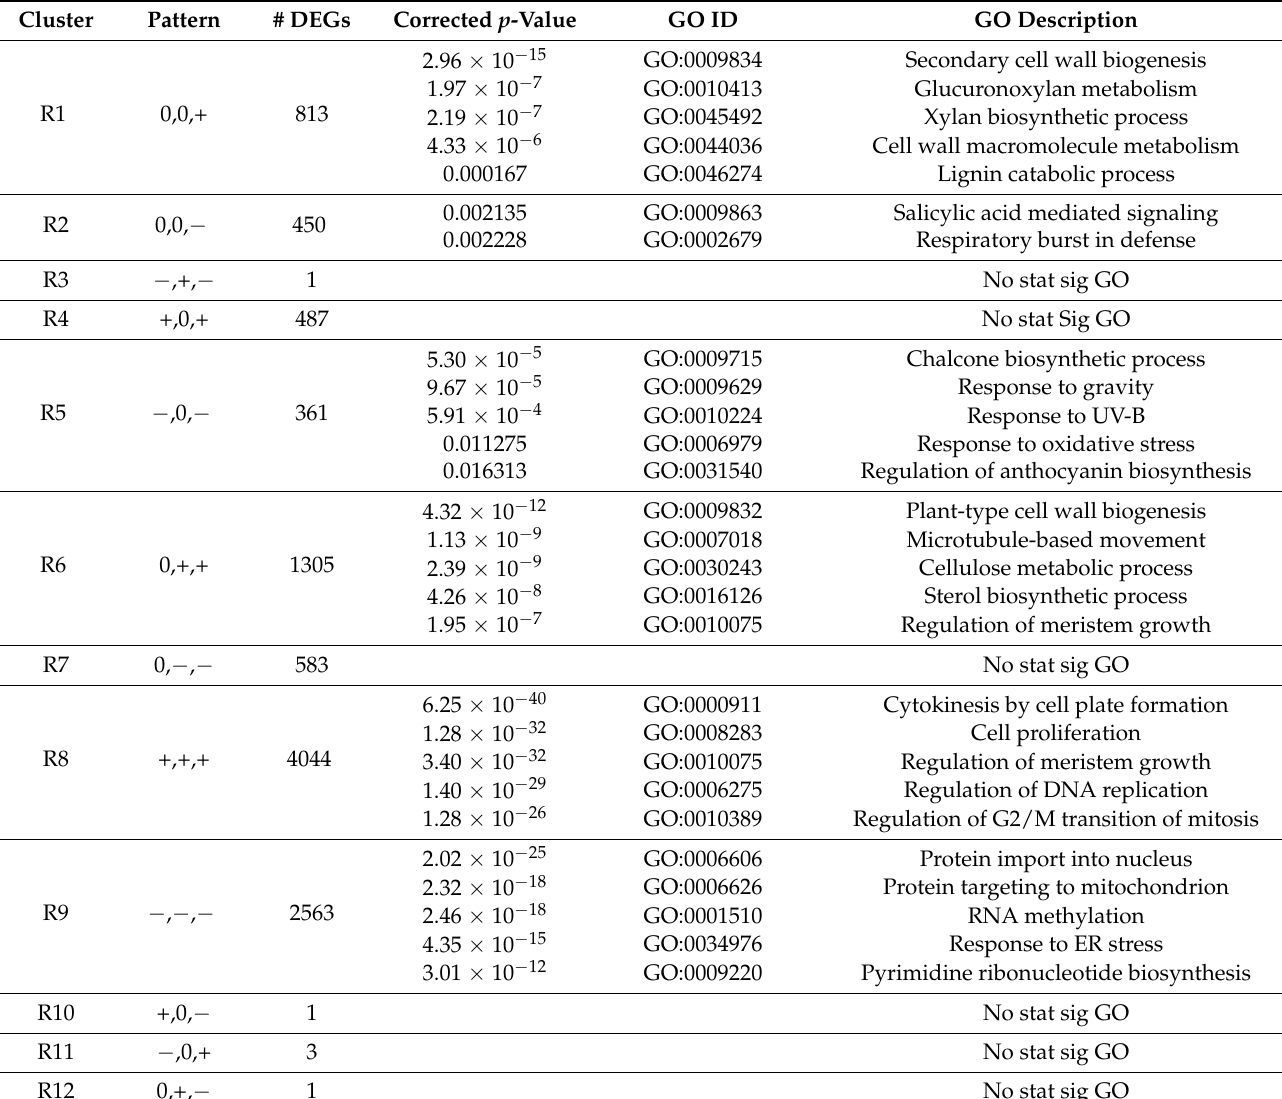
Cluster corresponds to list designation in Figure 2. Pattern reflects the gene expression pattern in -Fe-Fe, -P i -P i , and -Fe-P i samples: 0 indicates no significant change in expression, + indicates upregulated expression, - indicates downregulated expression. # DEGs indicates the number of differentially expressed genes assigned to each cluster. Corrected p -value is calculated using a Fisher’s exact test with a Bonferroni correction. Short horizontal lines separate information for multiple GO terms assigned to the same cluster. In roots, the majority of the DEGs (6608) are similarly differentially expressed in all three expression profiles. The GO processes associated with R8 and R9 include DNA replication, growth, photosynthesis, protein transport, and abiotic stress responses (Table 2, Supplementary File 1: Table S3). These are the hallmarks of the Clark genotype -Fe response [30]. Surprisingly in leaves, only 104 DEGs were differentially expressed in all three treatments; 52 upregulated and 52 downregulated (clusters L7 and L8). The genes in these two clusters represent the core soybean nutrient stress response, as supported by over-represented GO terms associated with stress responses (Table 1, Supplementary File